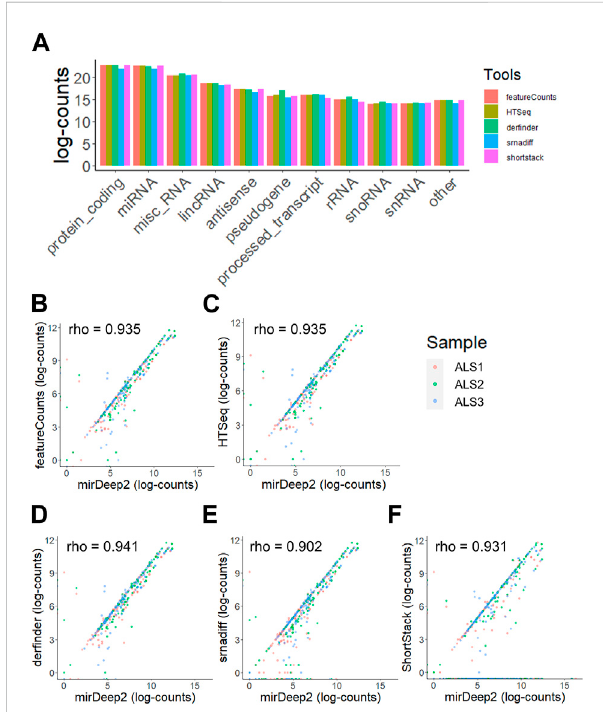
FIGURE 3 Distribution of reads across RNA types is not altered when using agnostic tools. (A) The distribution of reads aligning to speci fi c subclasses of RNA when using annotation-free methods. (B – F) Comparative quanti fi cation and rank correlation of miRNA with miRDeep2, featureCounts (B) , HTSeq (C) , der fi nder (D) , srnadiff (E) , and ShortStack (F) in three samples.